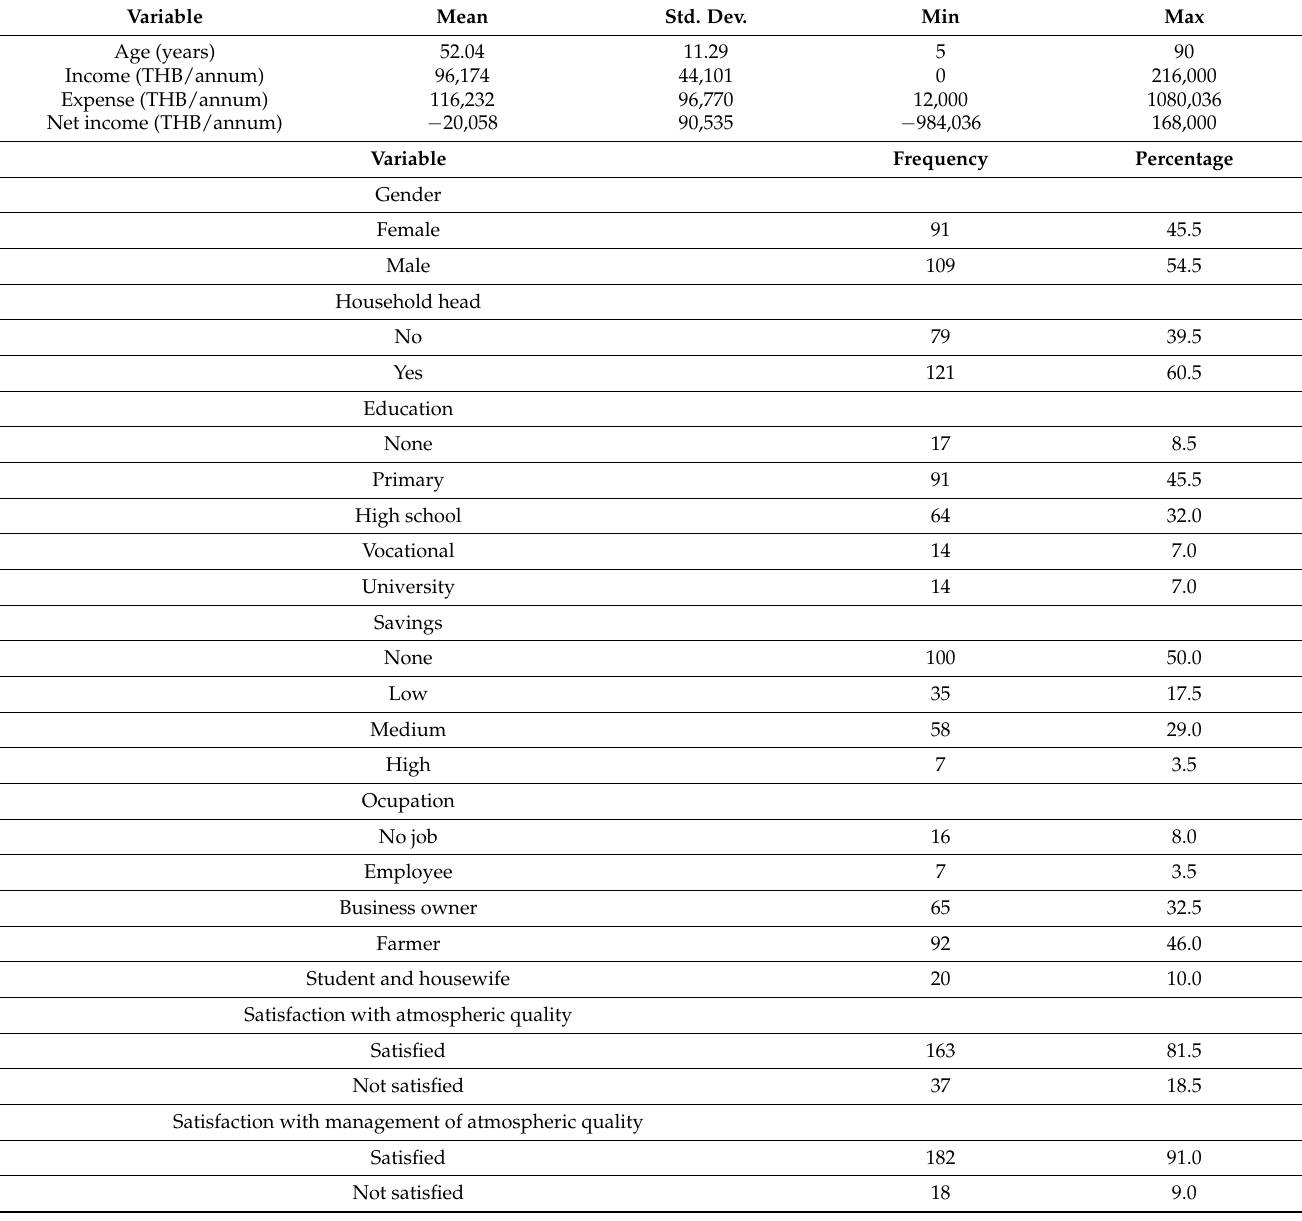
Table 5. Respondents’ socioeconomic profile ( n =